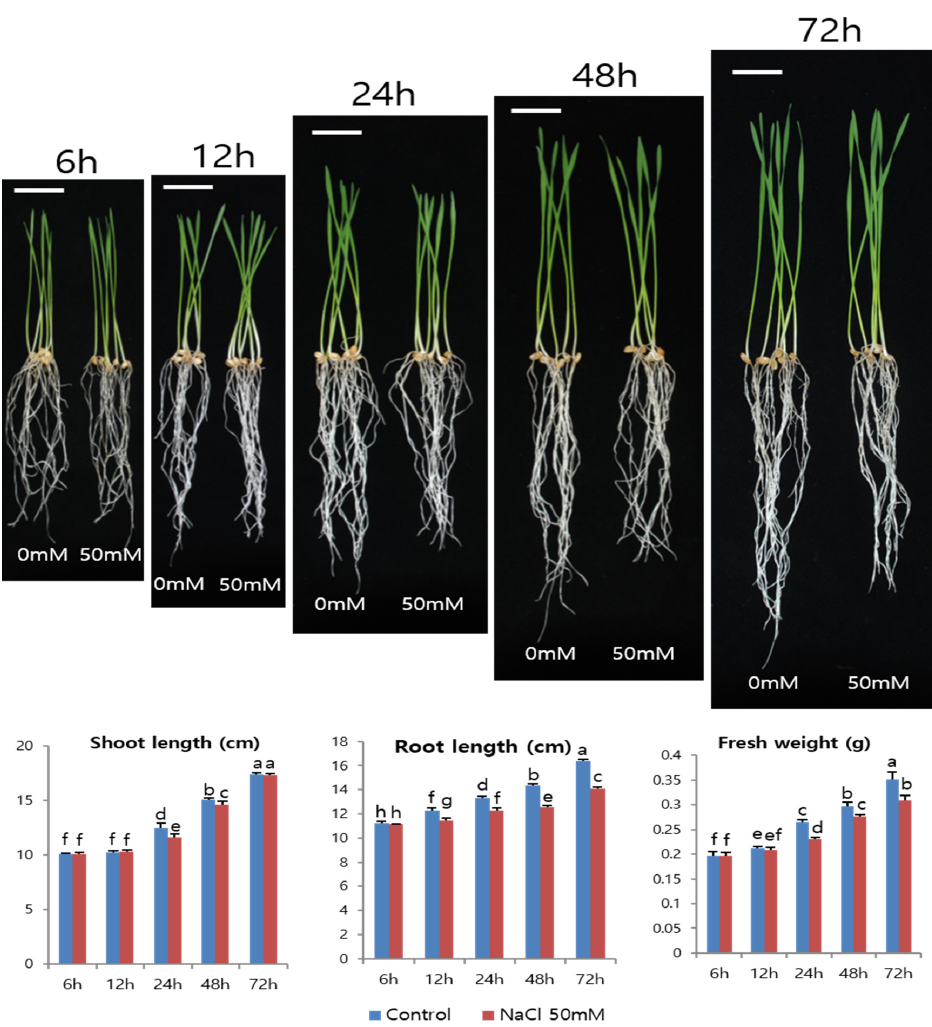
Figure 4. Wheat plantlet growth under control and 50 mM NaCl treatments. Six-day-old plantlets were treated with 0 mM and 50 mM NaCl for 6, 12, 24, 48, and 72 h. The means and SD were calculated from three biological replicates. Letters a-g denote significant differences ( P < 0.05). The scale bars represent 4 cm.